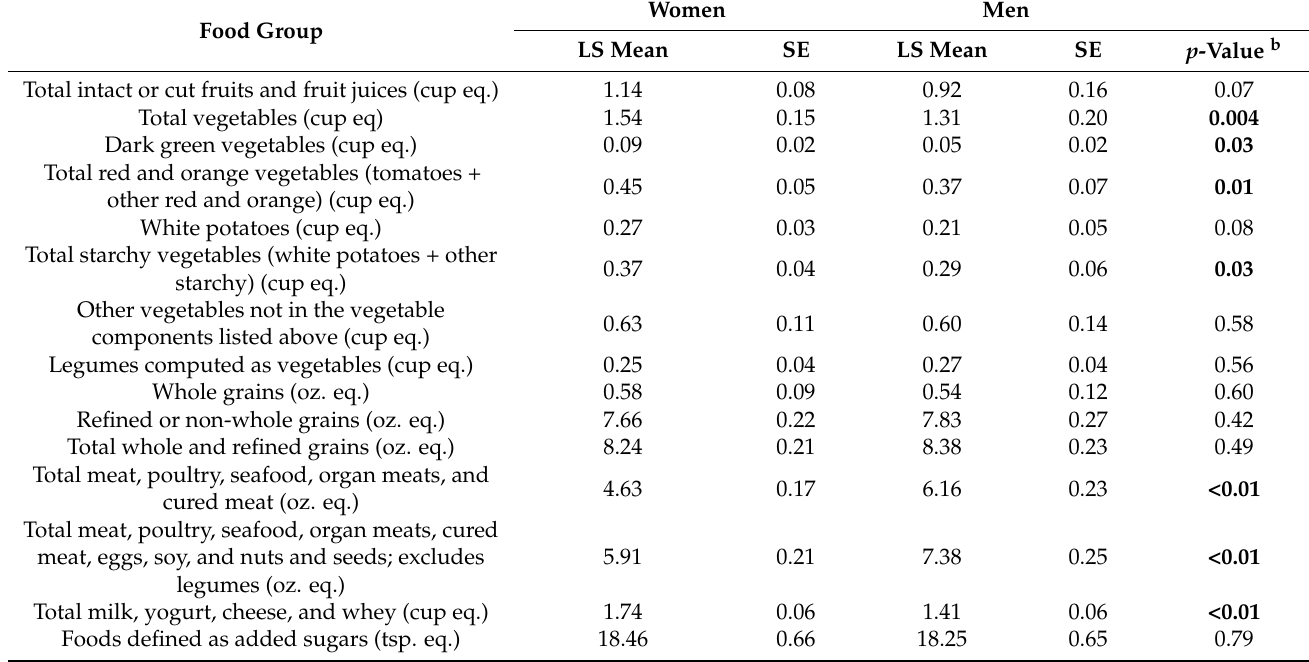
Table 2. Least square means of food groups and subgroups for women and men a